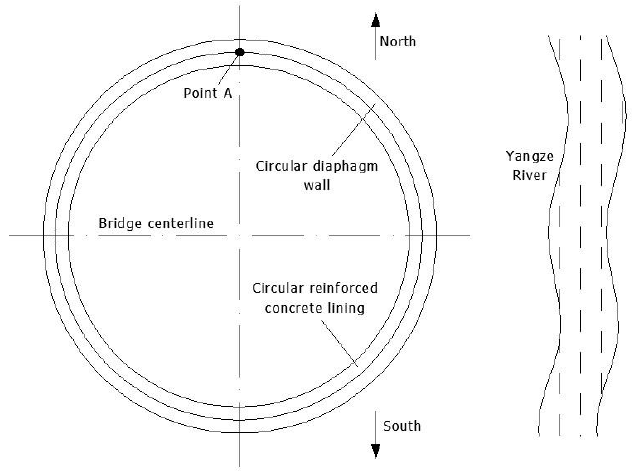
Figure 7. The position of Point A.